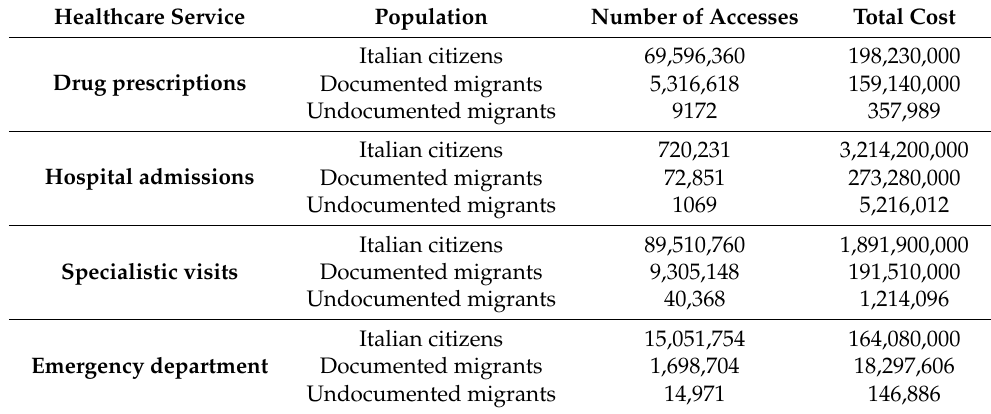
Table 2. Number of accesses and costs for different healthcare services, grouped by population.